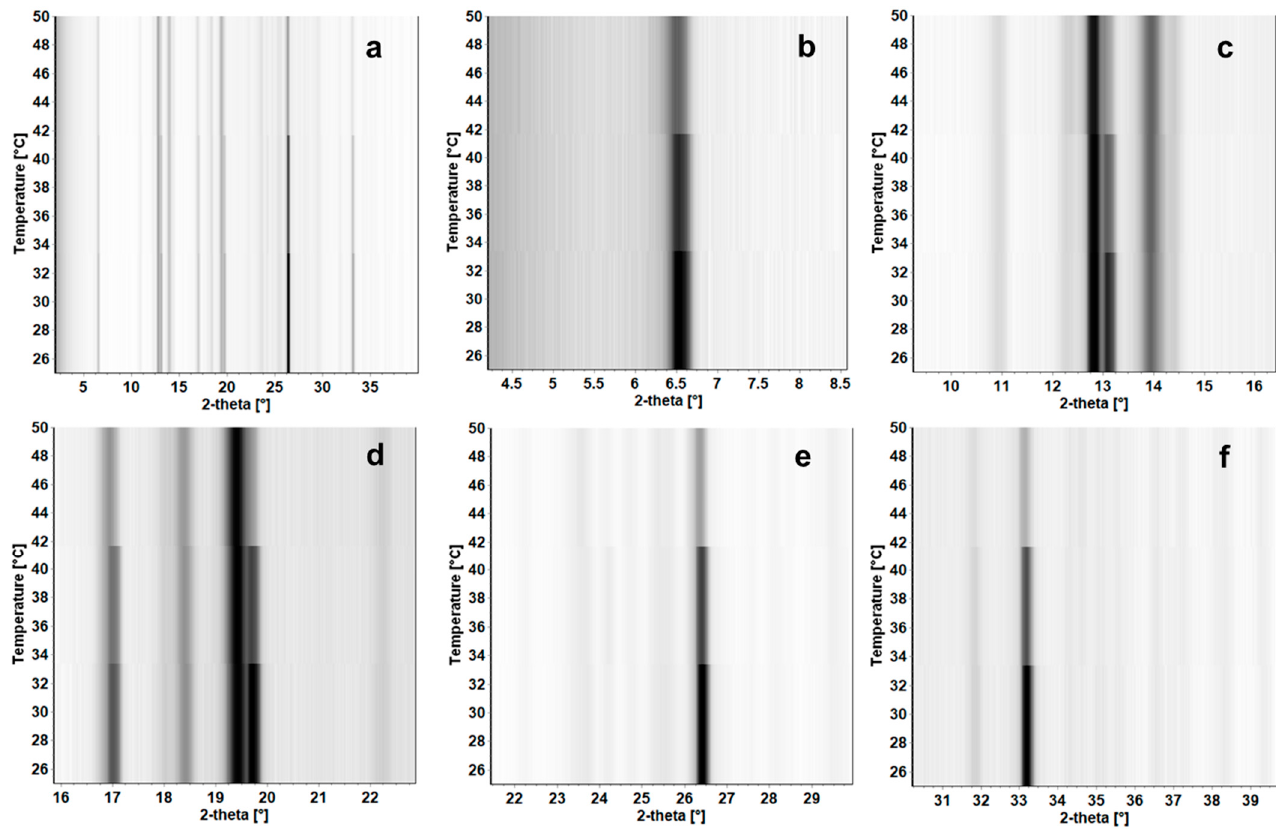
Figure 6. Isolines representing the compression of the unit cell at high temperature for form II for 2 ϴ range between 2 and 40° ( a ) and zoomed-in 2 ϴ regions between 4.0 and 8.5° ( b ), 9.5 and 6.5° ( c ), 16 and 22.5° ( d ), 22.0 and 29.5° ( e ) and 30.5 and 39.5° ( f ).